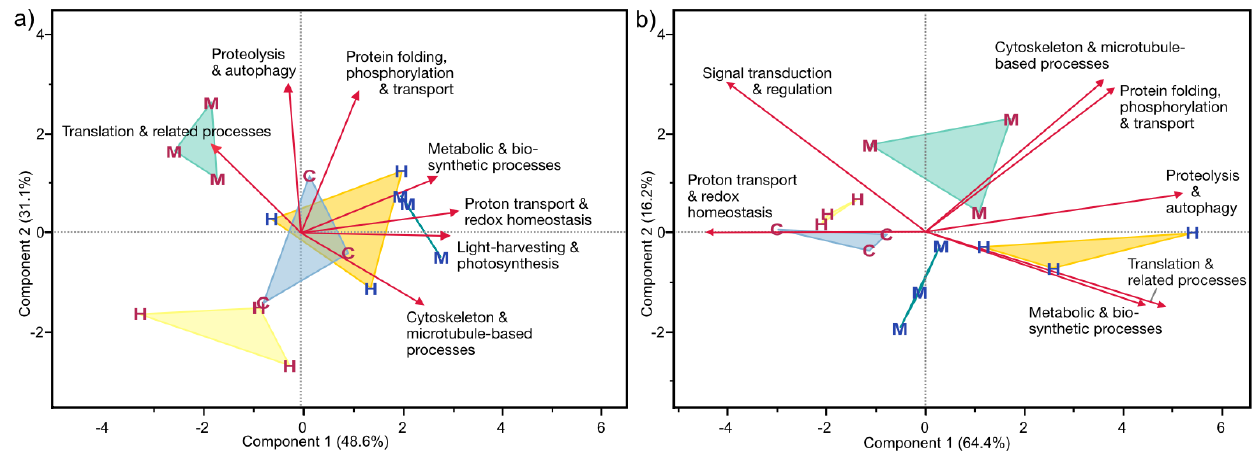
Figure 6. Principal component analyses of total normalized abundance values of the functional categories of ( a ) photosymbiont- and ( b ) host-associated DAPs in Amphistegina lobifera exposed to treatments of elevated p CO 2 (‘C’ = 492 ppm, ‘M’ = 963 ppm, ‘H’ = 3182 ppm) at 28 °C (blue) or 31 °C (red). Arrows indicate the direction and intensity of functional categories driving differences between the treatments, with triangles connecting the triplicate samples of each treatment (legend as in Figure 5).